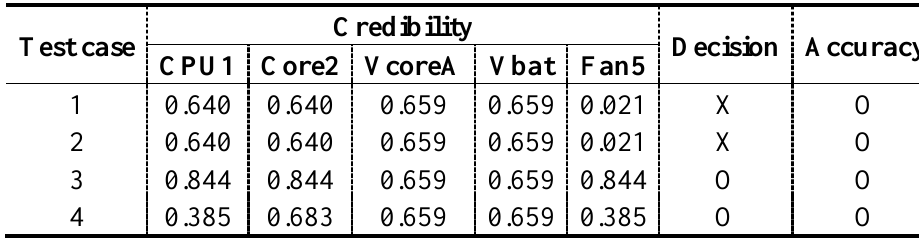
Table 10. Results of diagnostic model (C).